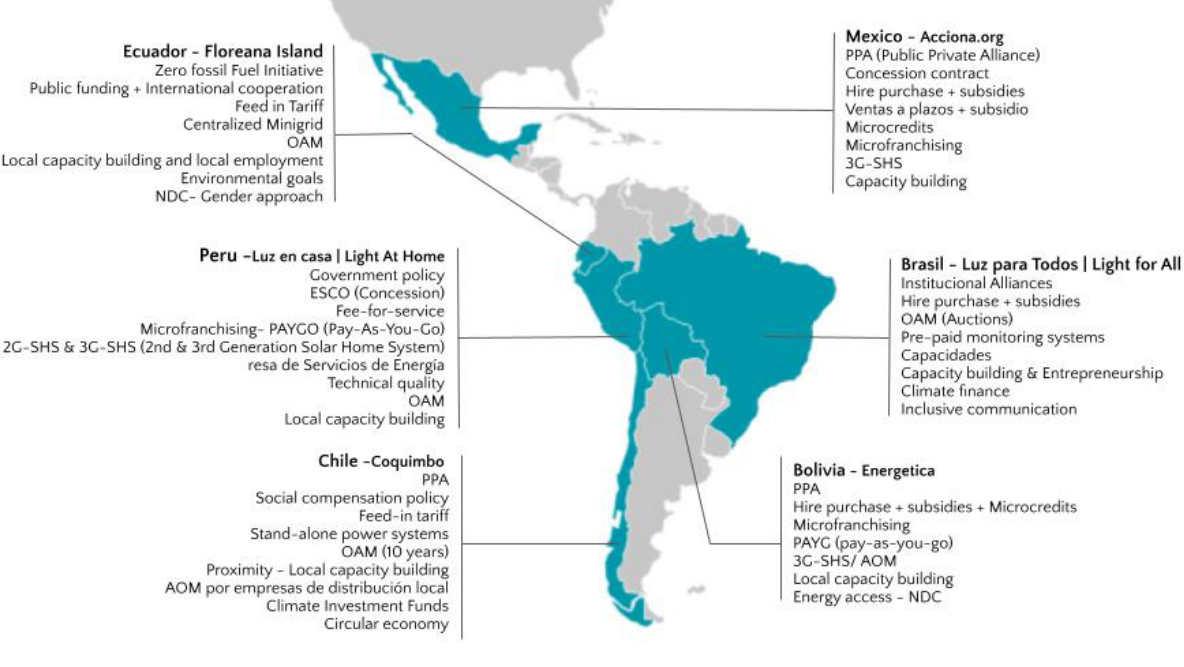
Figure 3. Successful Latin American case studies in rural electrification. Own elaboration.